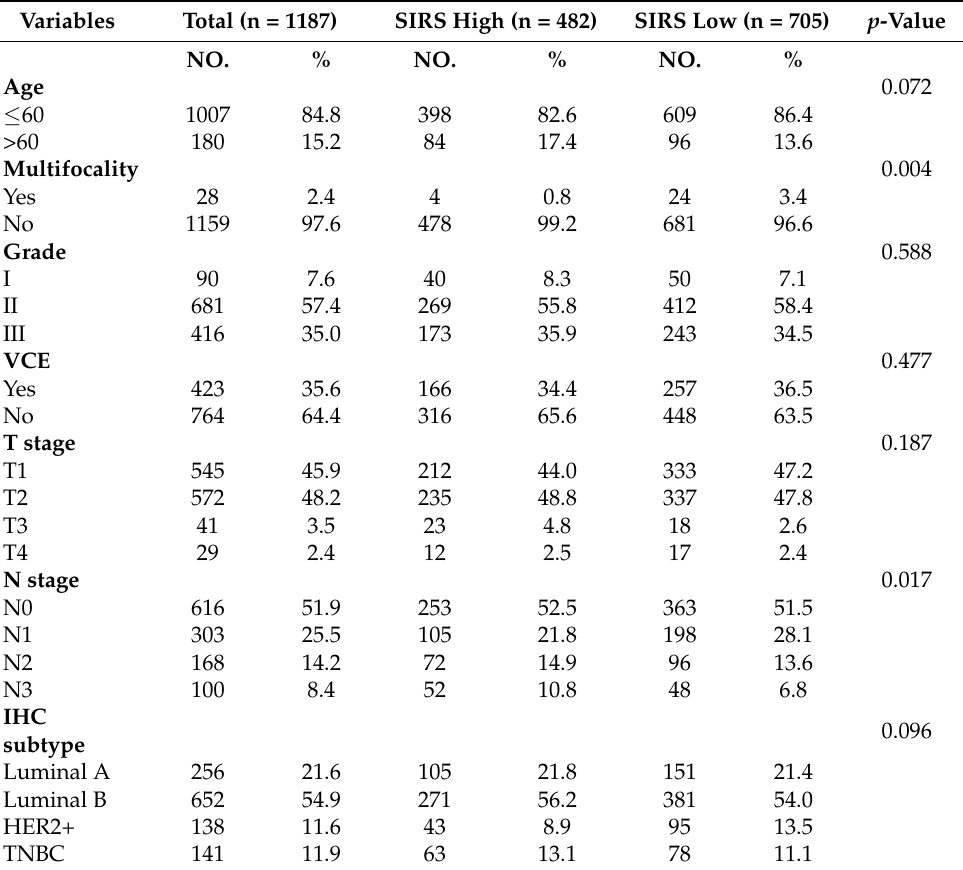
Table 2. Relationship between SIRS and clinical characteristics in training